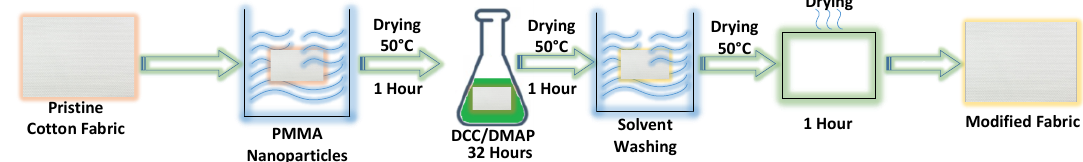
Figure 1. Flow diagram of the fabrication process of strongly hydrophobic and superoleophilic cotton fabric.